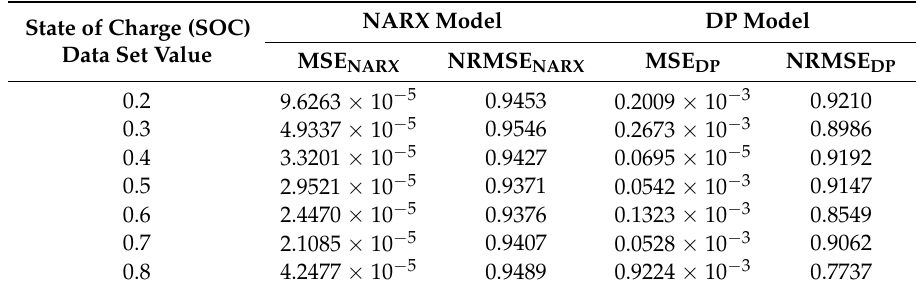
Table 2. Quality indices for NARX and DP models of the Valve-Regulated Lead-Acid (VRLA) battery. State of Charge